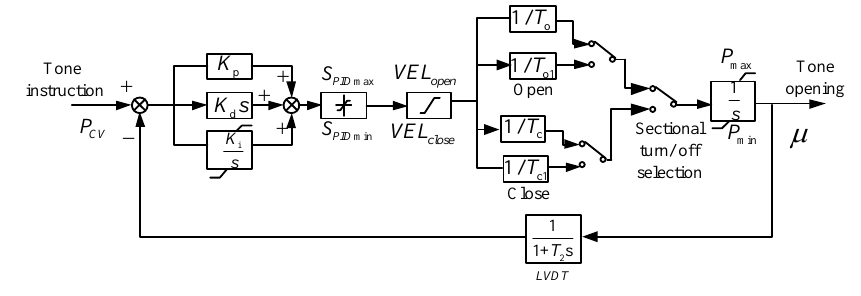
Figure 5. Electro-hydraulic servo system model.